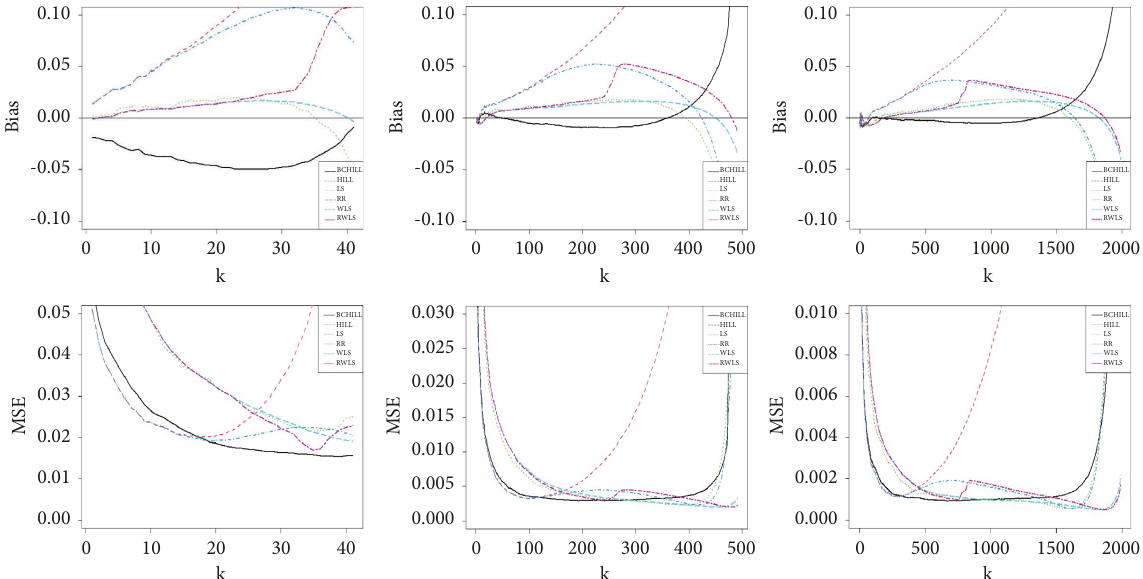
Figure 5: Results for Fr´echet distribution with c � 0 . 5: Bias (top row) and MSE (bottom row). First column: n � 50; second column: n � 500; and third column: n � 2000.